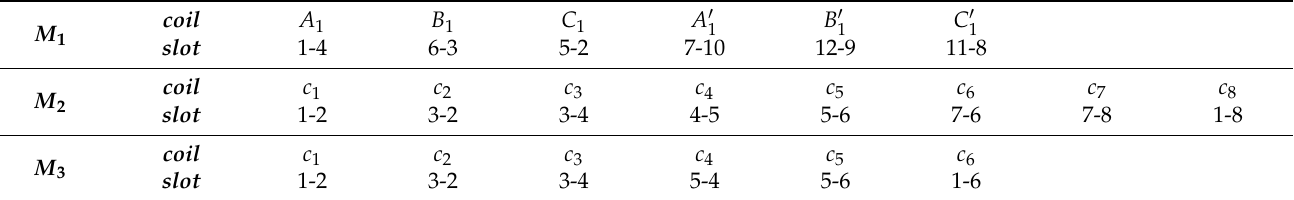
Figure 4. Winding layout of topologies M 1 ( a ), M 2 ( b ), M 3 ( c